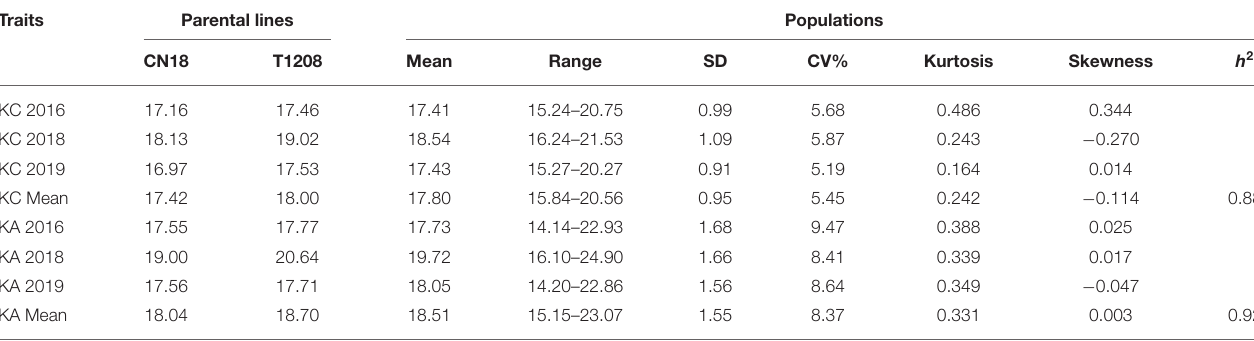
TABLE 1 | Phenotypic variation and heritability of characters in different environments in parents and populations. Traits Parental lines Populations CN18 T1208 Mean Range